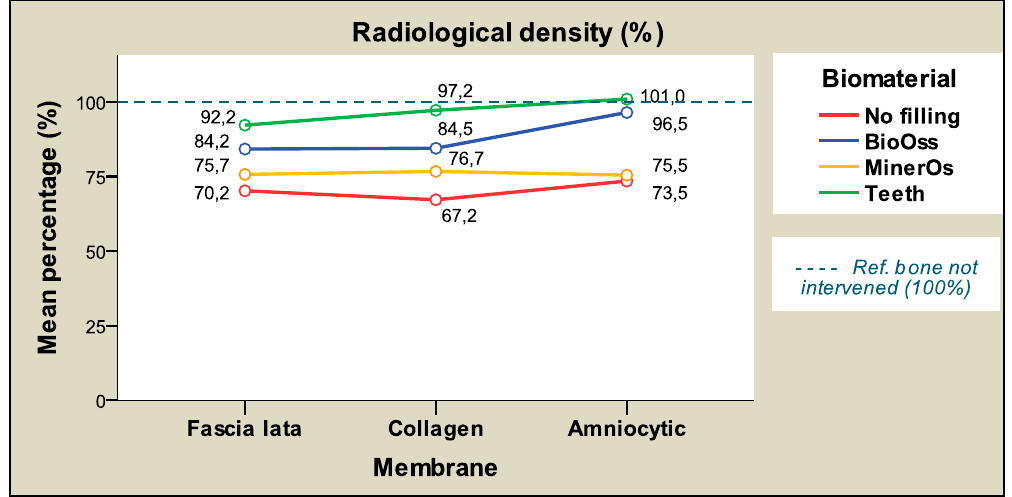
Figure 9 . The radiological density percentages (average) according to filling material and membrane . This corroborates and provides a graphic representation of the non-interaction between these variables. Figure 10 is a representation of the same data from a different perspective, showing the differences between filling materials and the only slight differences between membranes.